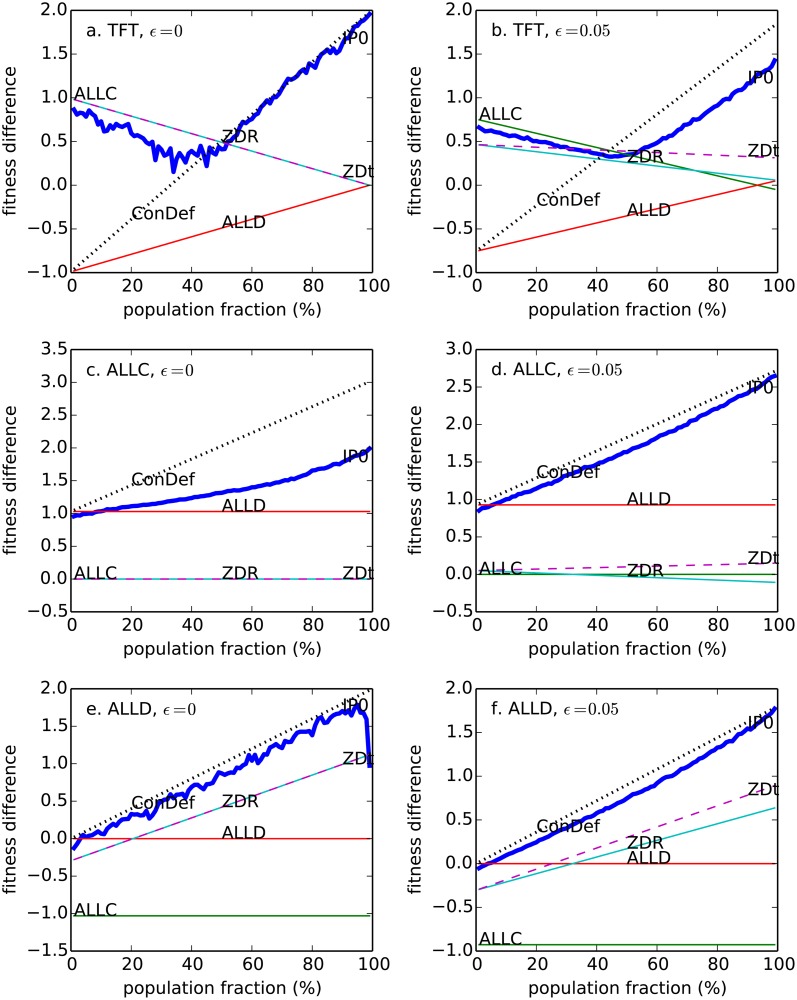
Mean fitness difference SI¯−SG¯ as a function of the invader’s population fraction.Plotted for several different invading strategies (I = ALLC, ALLD, ZDR, ConDef, ZDt) vs. several different resident strategies: TFT (A, B); ALLC (C, D); ALLD (E, F).